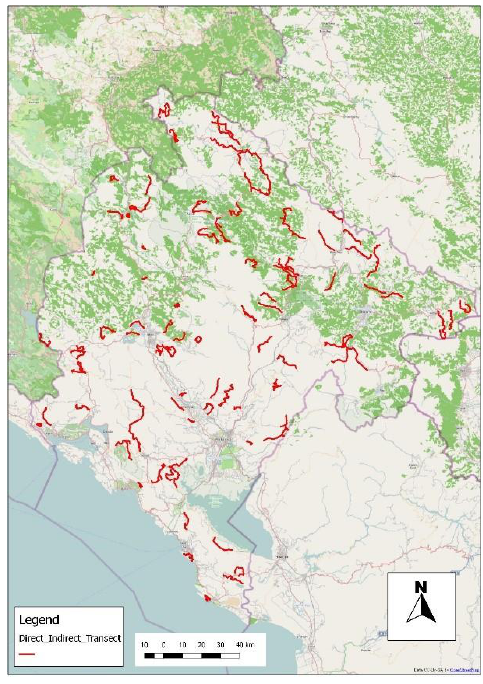
Figure 1. Montenegro wildlife monitoring net during 2011 and 2012. The monitoring transects are represented with a red line.